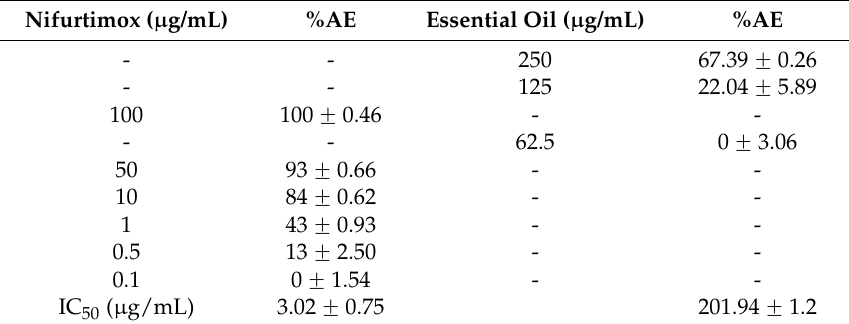
Table 2. Activity of essential oil from leaves of L. camara against T. cruzi